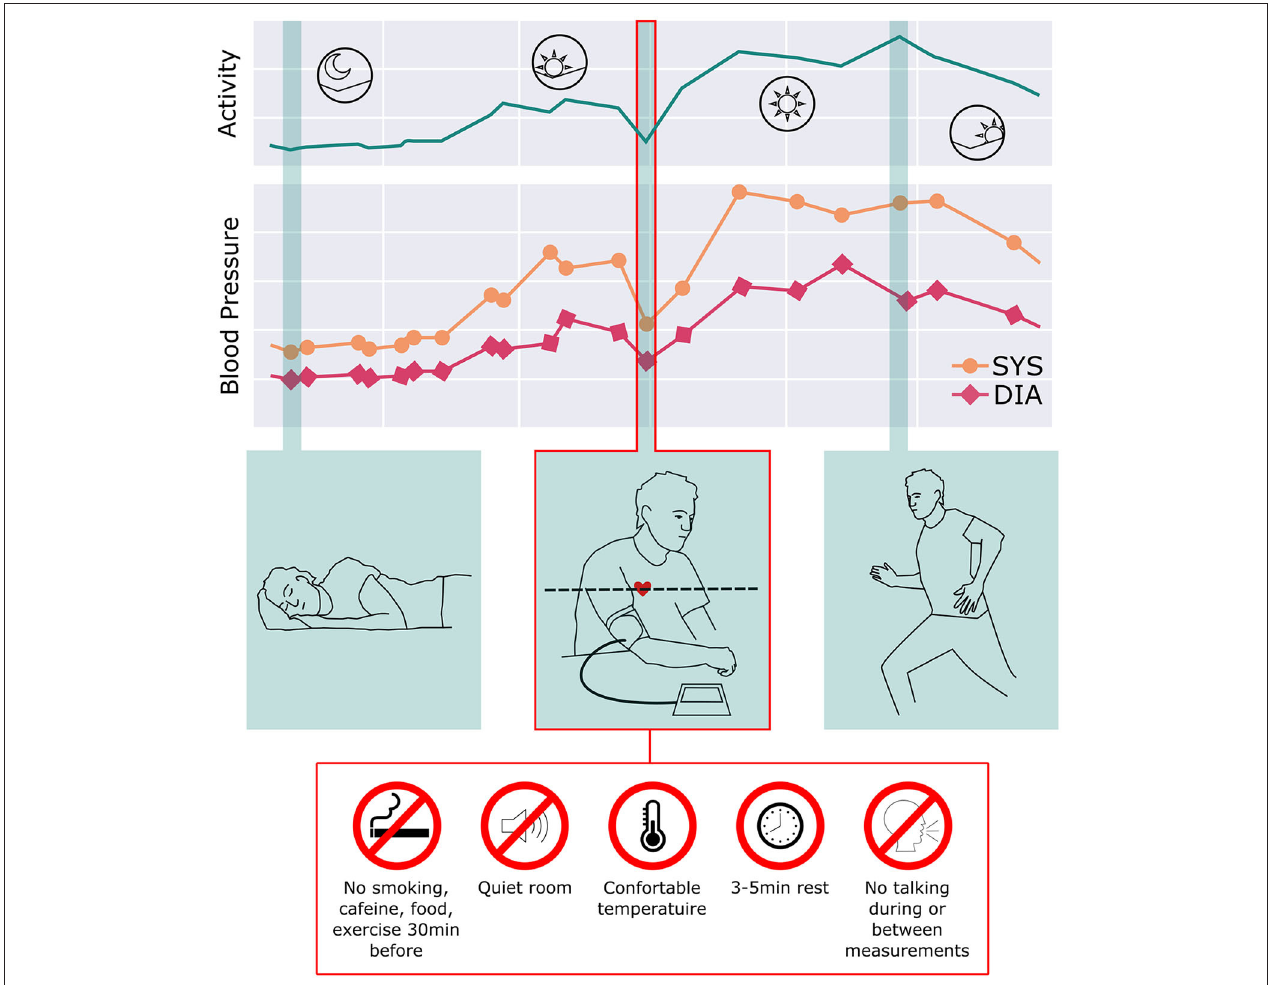
FIGURE 1 | BP continuously changes and adapts over 24 h according to lifestyle, daily activities, medication treatment, and body position changes. While this reflects the natural variability of BP, current guidelines recommend obtaining BP readings using the Framingham methodology: sitting relaxed in a quiet, climate-controlled room. Given the daily variation of BP through the day, this method provides a poor representation of the BP over the day as well as long periods of time.